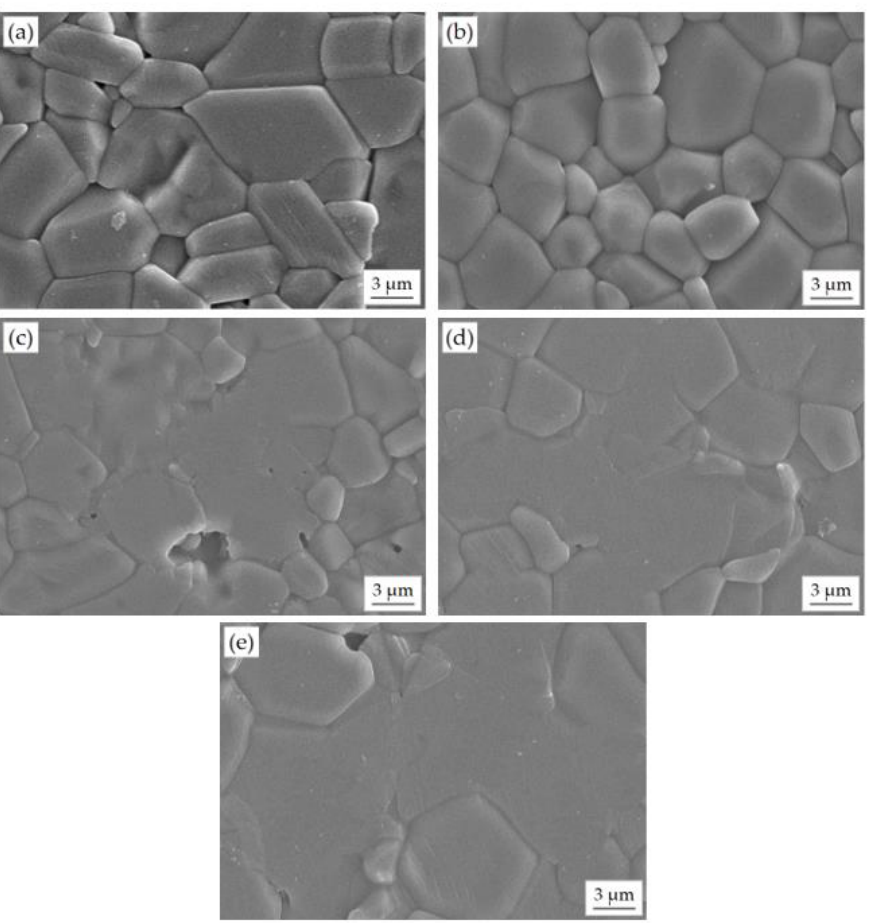
2 O 3 ceramic pellets.